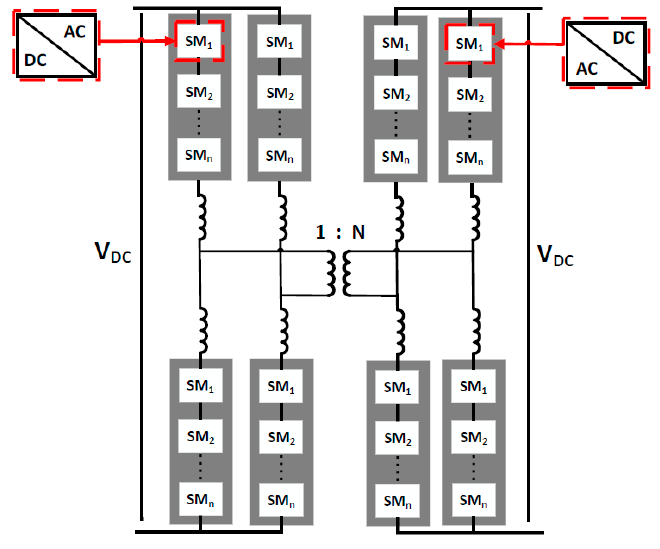
Figure 6. MMC DAB.